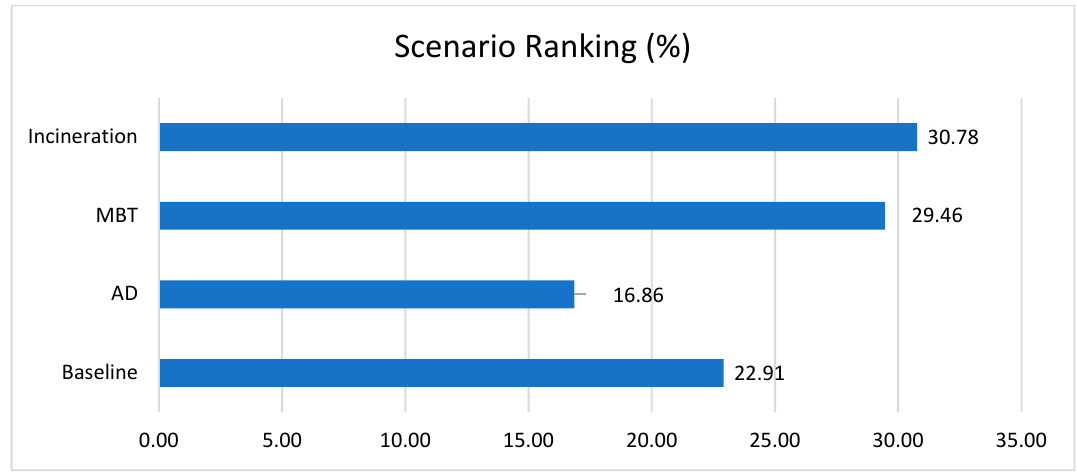
Figure 5. Ranking of scenarios.